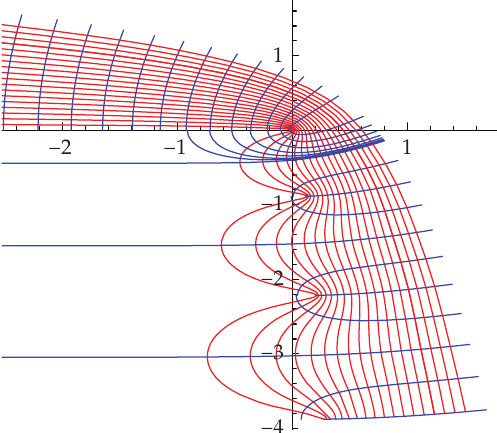
(cid:10) z (cid:5)Γ(cid:5) 1 / 2 − x (cid:6) / Γ(cid:5) − x (cid:6)(cid:6) − 1